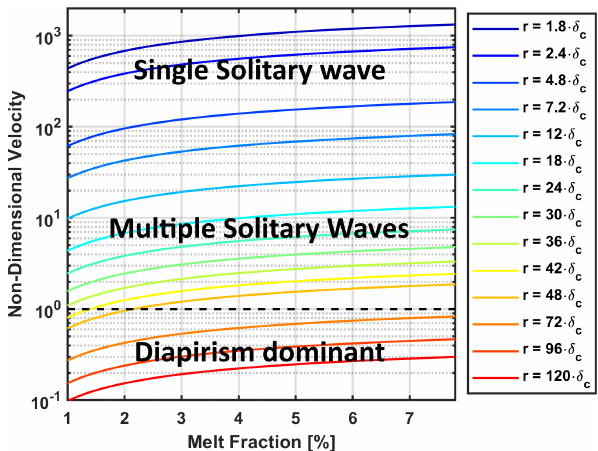
Figure 4. The dashed line marks the velocity of the Stokes sphere ( v (cid:48) = 1 ) . The colored lines refer to the velocity of a 2D solitary wave, calculated semi-analytically by Simpson and Spiegelman (2011), in our non-dimensionalization, based on the radii shown in the